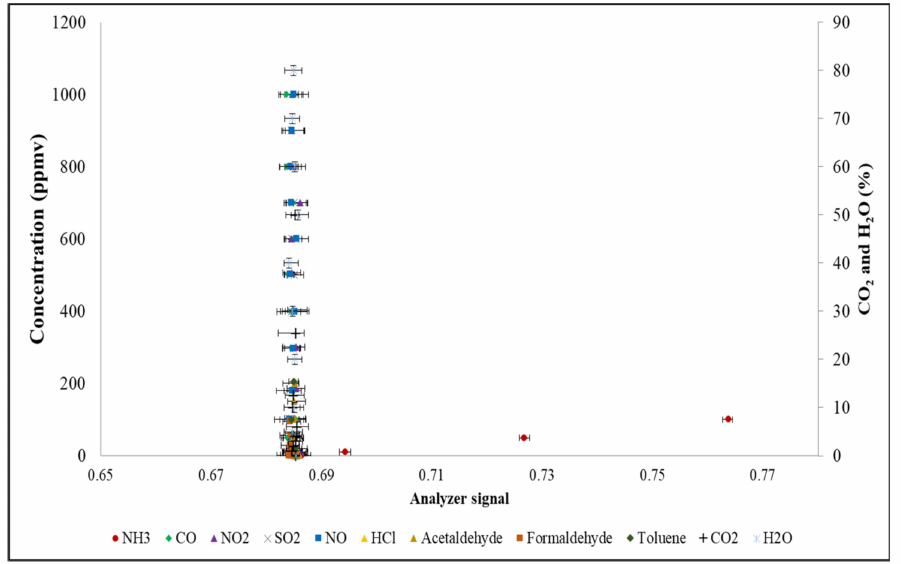
Figure 5. Relationship between target gases’ concentrations and analyzer signals. (Error bars denote minimum and maximum